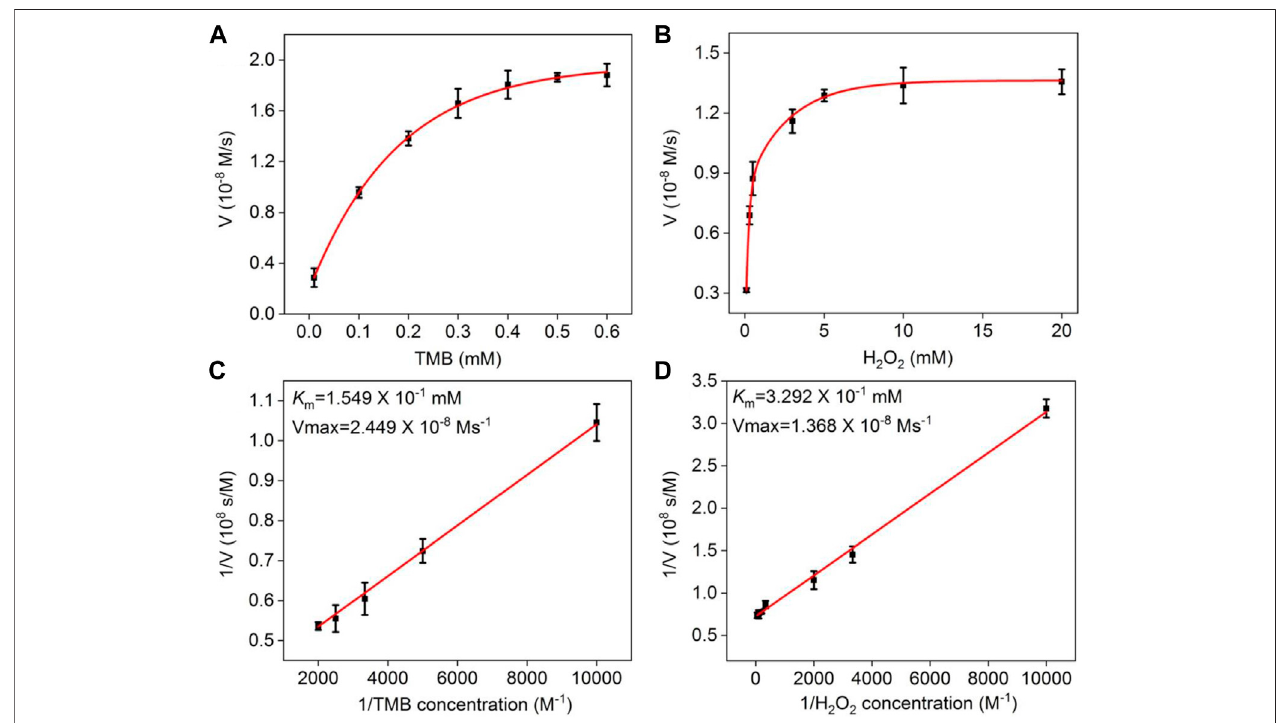
FIGURE5|(A,B) Steady-statekineticassayofNGQDs,inwhichthereactionvelocityisdeterminedthroughoxidation ofTMBbasedonabsorptionat652 nmwith varyingconcentrationsof (A) TMBor (B) H 2 O 2 . (C,D) Double-reciprocalplotsofNGQDactivity obtainedusingMichaelis – Mentenmodelata fi xedconcentrationofH 2 O 2 (c, 6.6 mM) or TMB (d, 0.5 mM) versus various concentrations of TMB (C) or H 2 O 2 (D)